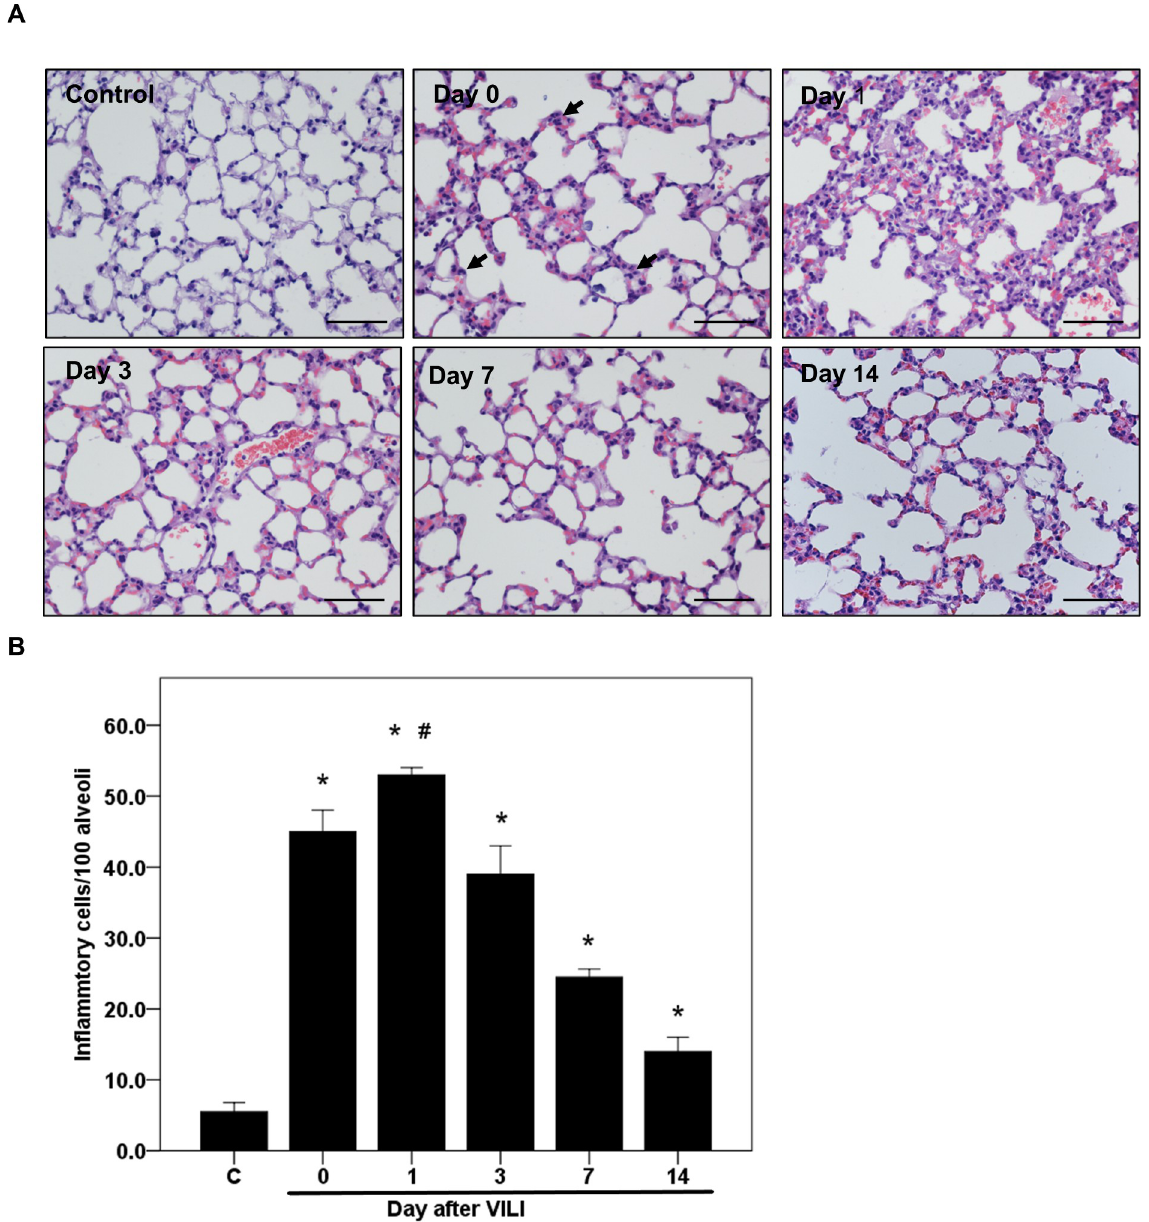
Fig 1. Time course of lung inflammatory cell response following VILI as determined from histological analysis. C57BL/6 mice received 20 ng LPS intraventricularly and HTV ventilation to produce a two-hit VILI. The mice were sacrificed immediately after VILI (day 0) or on days 1, 3, 7, or 14 after VILI. (A) H&E staining of the lung sections of mice sacrificed at different time points (original magnification: 200 × ). The closed arrow indicates lung-recruited inflammatory cells, including neutrophils and monocytes. (B) Quantification and comparison of the inflammatory cells in lung sections from individual mice sacrificed at different time points. Scale bar = 200 μ m. Statistical analysis was performed using one-way ANOVA with Bonferroni’s post hoc test. Data are expressed as means ± SD; n = 3–5 per group, � p < 0.01 vs. normal control (C) and # p < 0.01 vs. day 0 and day